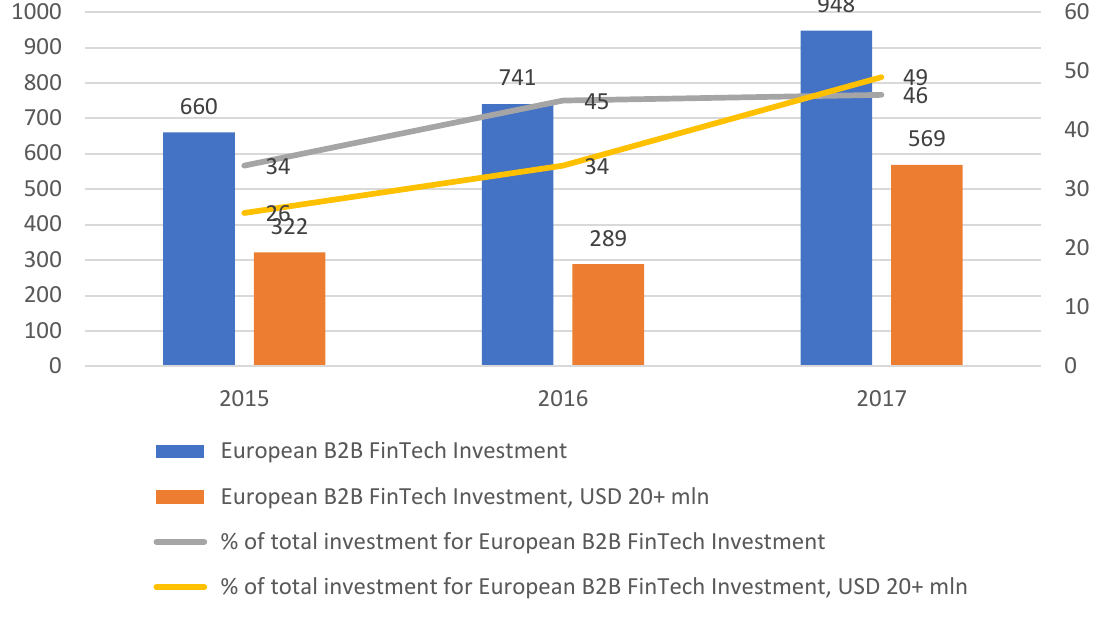
Figure 5. Investment into B2B FinTech in the EU countries, mln.